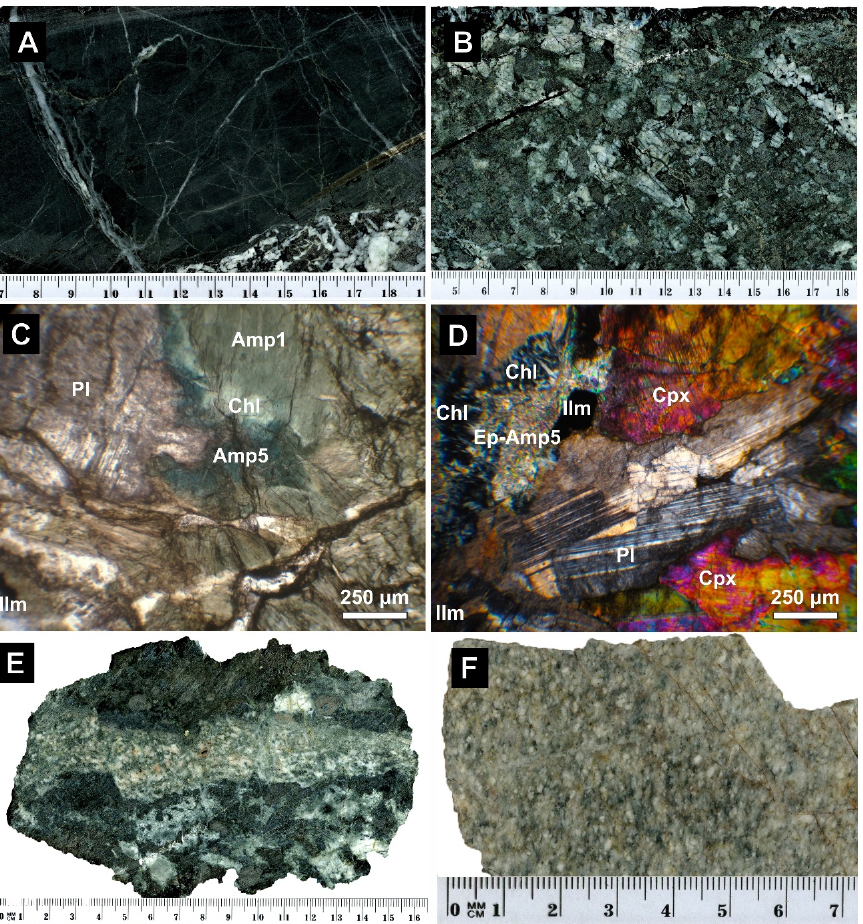
Figure 12. Gabbros and a plagiogranite from inferred gabbro layer of the OOC oceanic crust from a borehole core (P10A–C), ophiolitic breccia (P13B1, P13B2), and an intrusive body (P5). ( A ) Gabbro (P10A) crosscut by a basalt (dark) dyke (P10D). ( B ) Cpx ‐ Pl ‐ Amp gabbro (P10C). ( C ) PL microscopic image of Cpx ‐ Pl ‐ Amp ‐ Ilm gabbro (P10C) with blue ‐ green rim of Amp5(Tr, Act) on Amp1(Mhb, Prg). ( D ) PL microscopic image of Cpx ‐ Pl gabbro (P10B) with secondary fine ‐ grained aggregate of Amp5, Czo, Ep, Chl. ( E ) Gabbro (P13B1) crosscut by a leucogabbro vein (P13B2). ( F ) Plagiogranite (P5). Picture C at II P; D at X P.